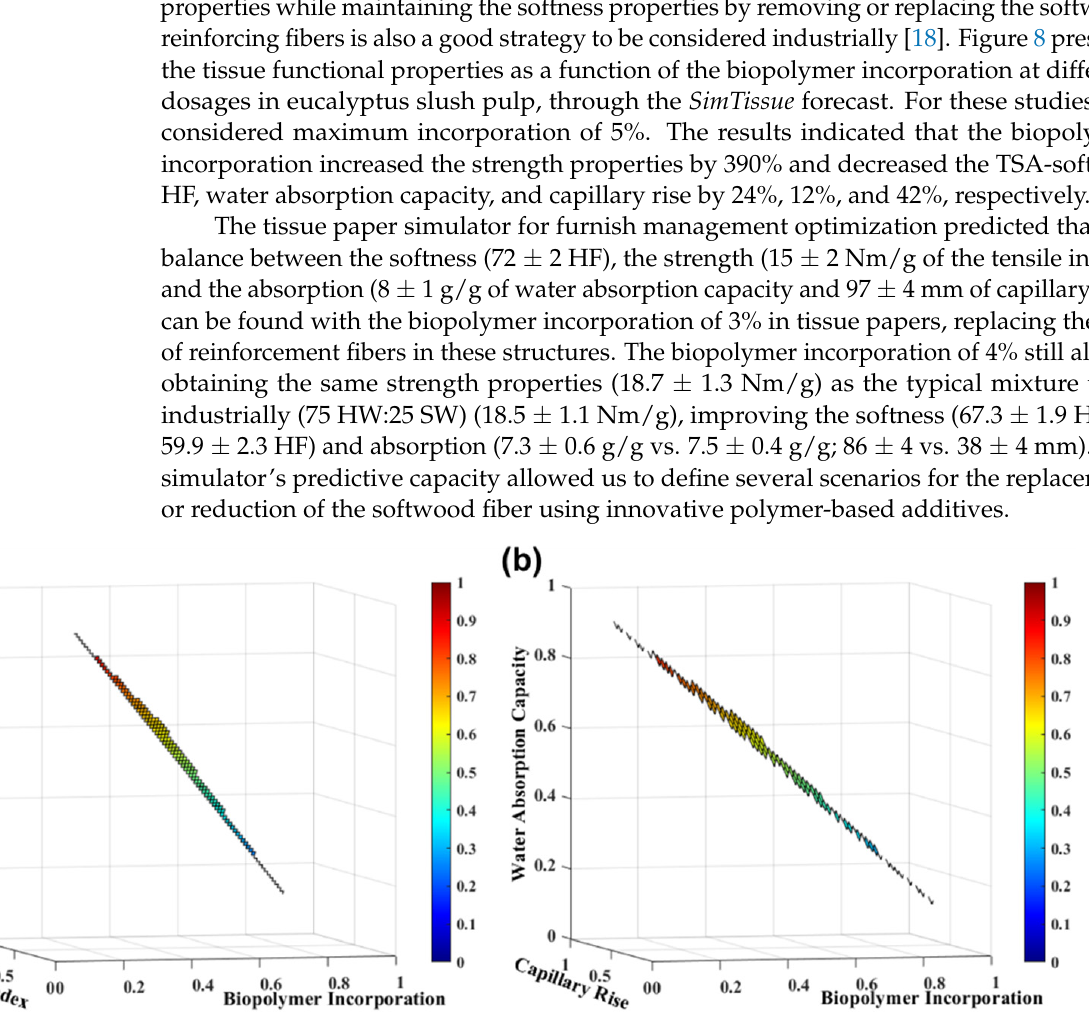
Table 1. Examples of case studies of different furnish scenarios to design new multi-structured in- novative tissue paper materials.